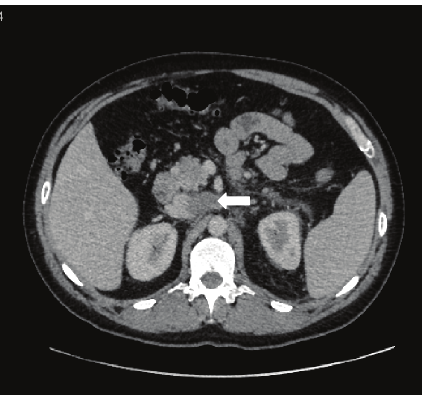
Figure 1: Computerized tomography (CT) scan of the abdomen demonstrating the thrombus extended from the left renal vein to the IVC. The arrow indicates the 40 mm thrombus.